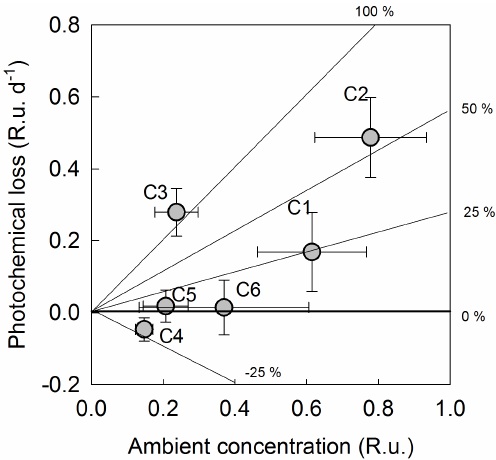
Figure 6. Average loss of specific fluorescence components based on the difference in concentration before and after irradiation for samples originating from boreal lakes, rivers and wetlands. Rates have been reported on a per day basis based on the average of the FDOM (fluorescent DOM) loss measured after 12 and 24h; this allowed us to better quantify the photochemical susceptibility of C3 which was commonly completely degraded after 24h, hence the average per day loss of over 100%. n =